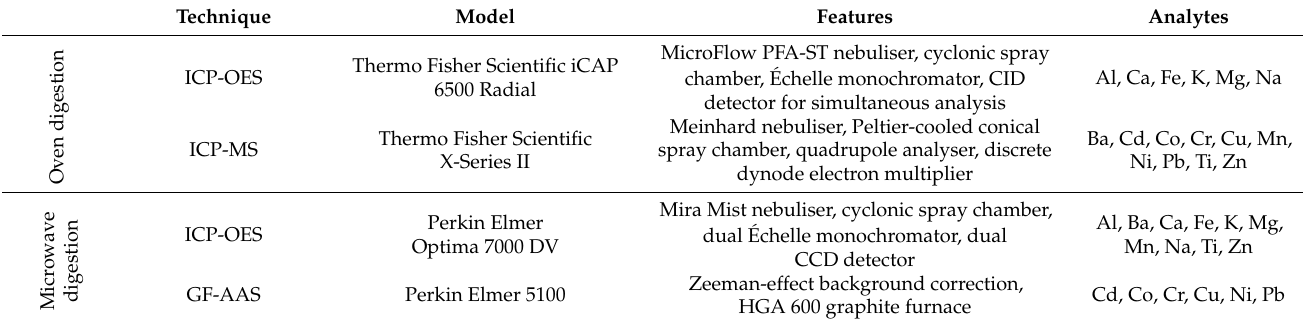
Table A2. Instrumental techniques used for analysis of oven-digested and microwave-digested samples.